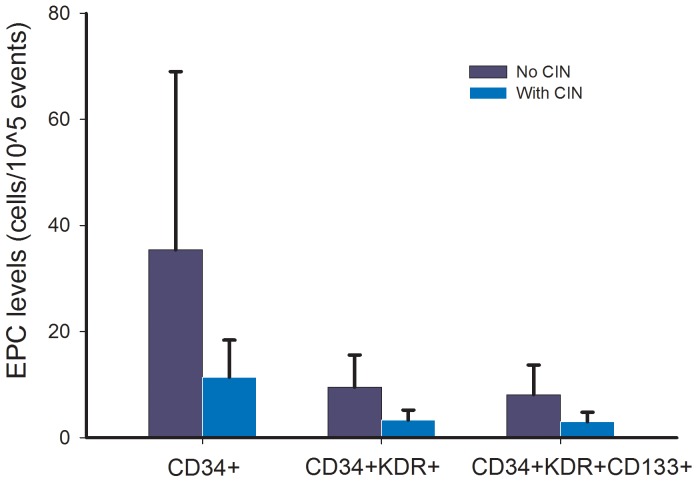
EPC levels (cells/105 events) in patients with and without development of contrast-induced nephropathy (CIN) (values presented as means ± standard deviation).